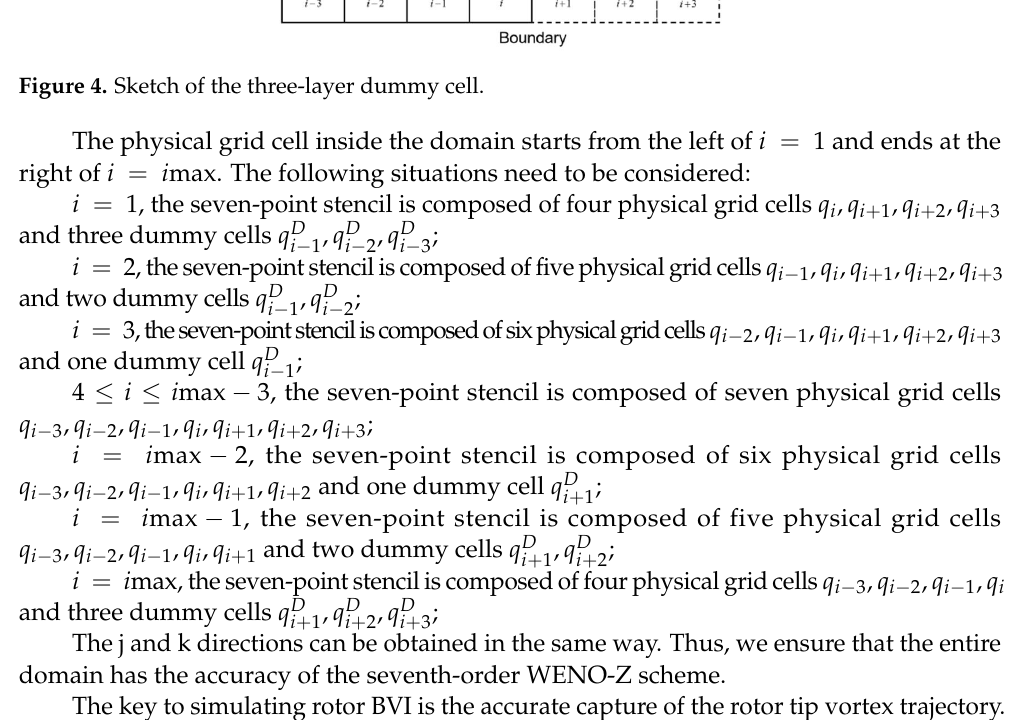
1 i  and ends at the